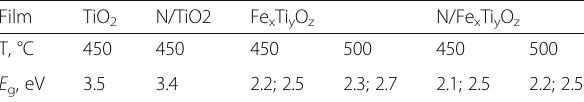
Table 1 The band gap ( E g ,) values of undoped and doped with urea TiO 2 and iron titanate films